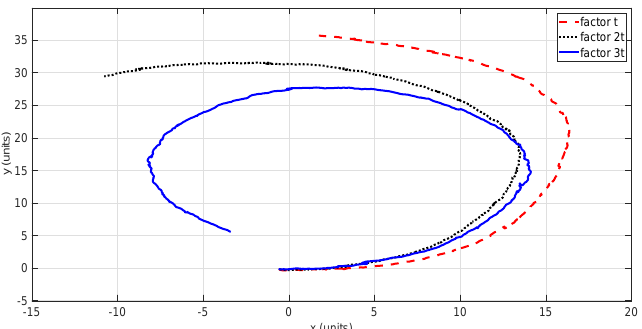
Figure 8. Steering behavior of the robot with different timing factors associated with the rotational matrix. The inner side leg stepping amplitude is reduced and at the same time the inner side wheg speed is decreased acting on the time-dependent rotational matrix R ( φ ( t ))